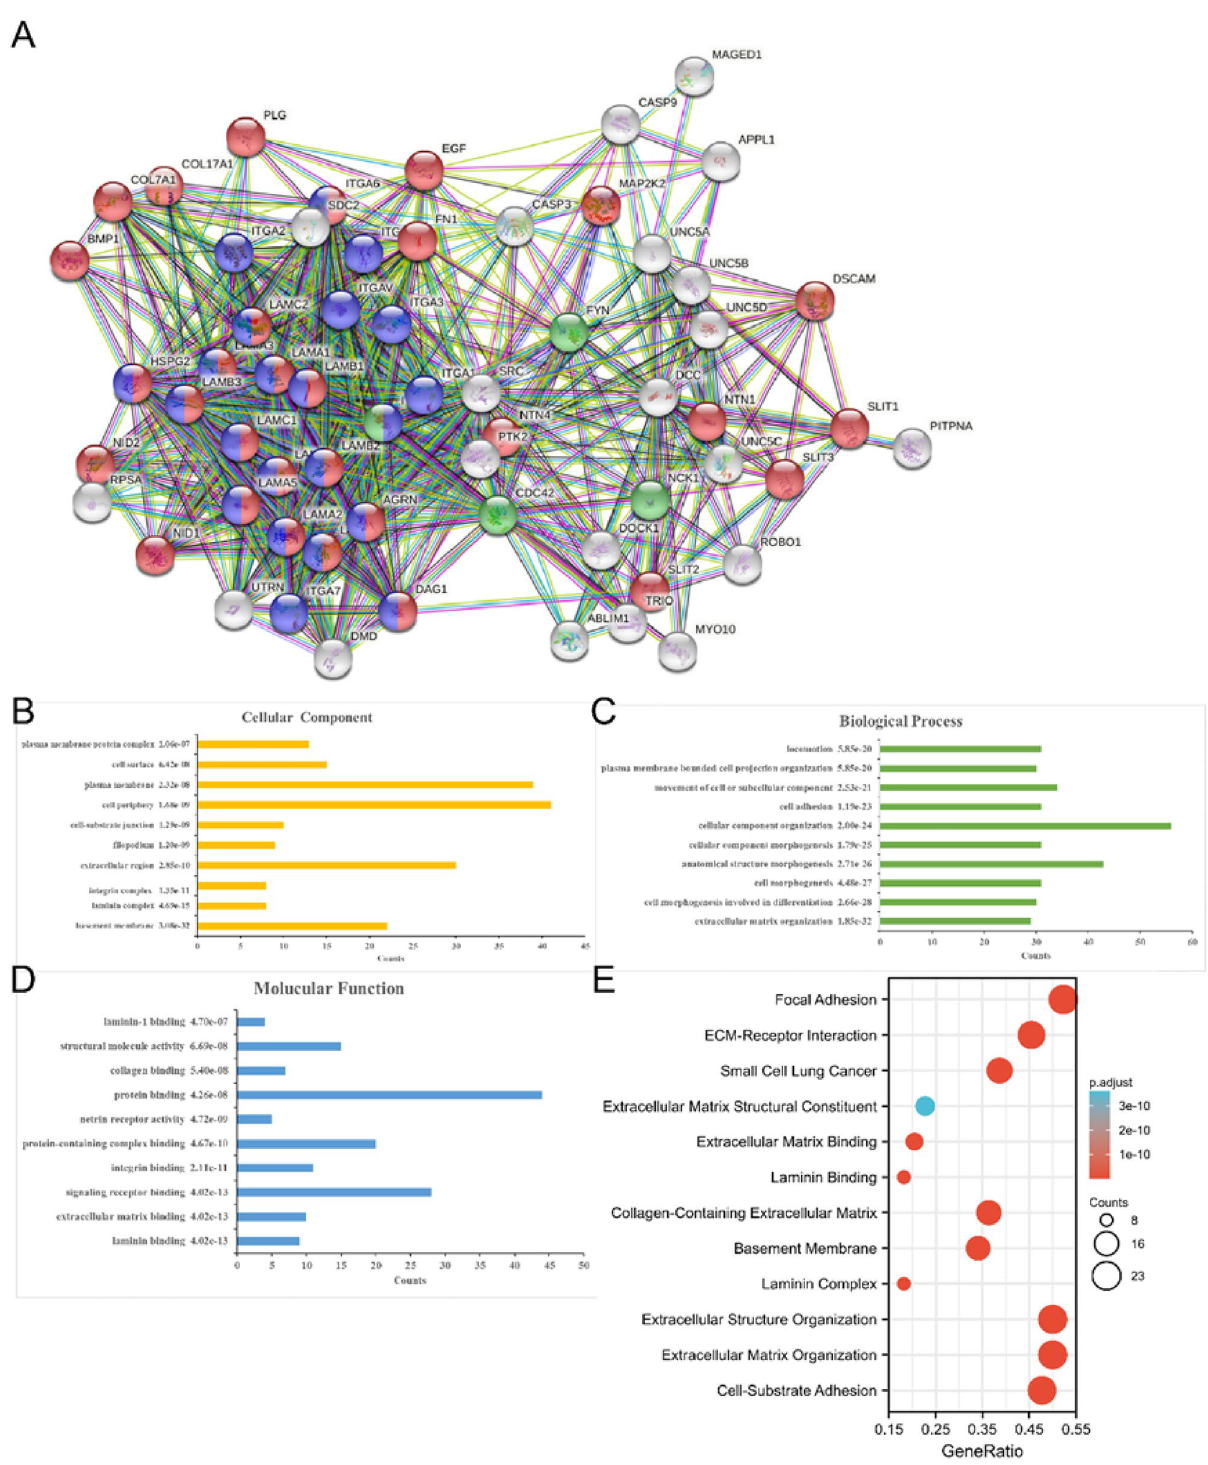
Figure 7. Exploration of NTN4 molecular functions and regulation pathways based on bioinformation tools. ( A ) Interaction network of NTN4 based on the STRING database. ( B ) Cellular component. ( C ) GO biological process. ( D ) Molecular function. ( E ) Enrichment analysis based on GO and